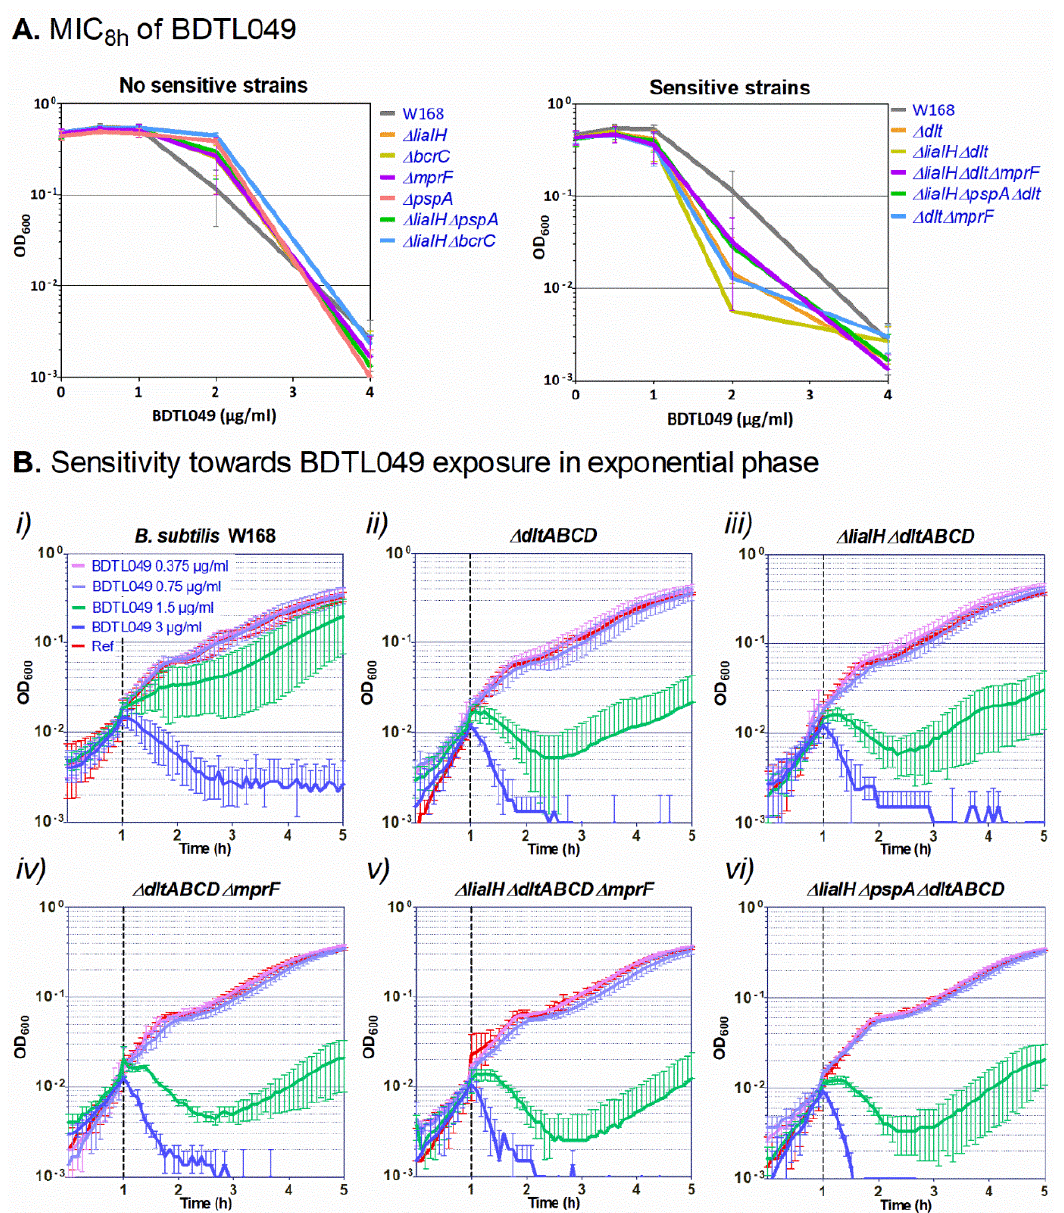
Figure 4. Sensitivity assays of B. subtilis W168 and derivative mutant strains exposed to the synthetic antibiotic BDTL049. ( A ) MIC after 8 h of growth in the presence of BDTL049. The cells were inoculated to an OD 600 of 0.05 in MH with 2-fold serial dilutions of BDTL049, and the cultures were incubated in aerobic conditions at 37 ◦ C. The values of OD 600 after 8 h of incubation in the presence of the compound are plotted as a function of the antibiotic concentration to determine the MIC 8h . Results present the mean and standard deviation of three replicas. ( B ) The effect of the addition of increasing concentrations of BDTL049 on the growth of exponentially growing cells was determined by monitoring OD 600 over time. The time of compound addition is indicated with a vertical black dashed line. The compound concentrations are indicated in graph (i ). The results presented correspond to strains: (i) , B. subtilis W168; (ii) , ∆ dltABCD (TMB5498); (iii) , ∆ liaIH ∆ dltABCD (TMB5499); (iv) , ∆ dltABCD ∆ mprF (TMB5512); (v) , ∆ liaIH ∆ dltABCD ∆ mprF (TMB5513); (vi) , ∆ liaIH ∆ pspA-ydjGHI ∆ dltABCD (TMB5500). The experiments were performed at least in triplicate. Means and standard deviations are depicted.